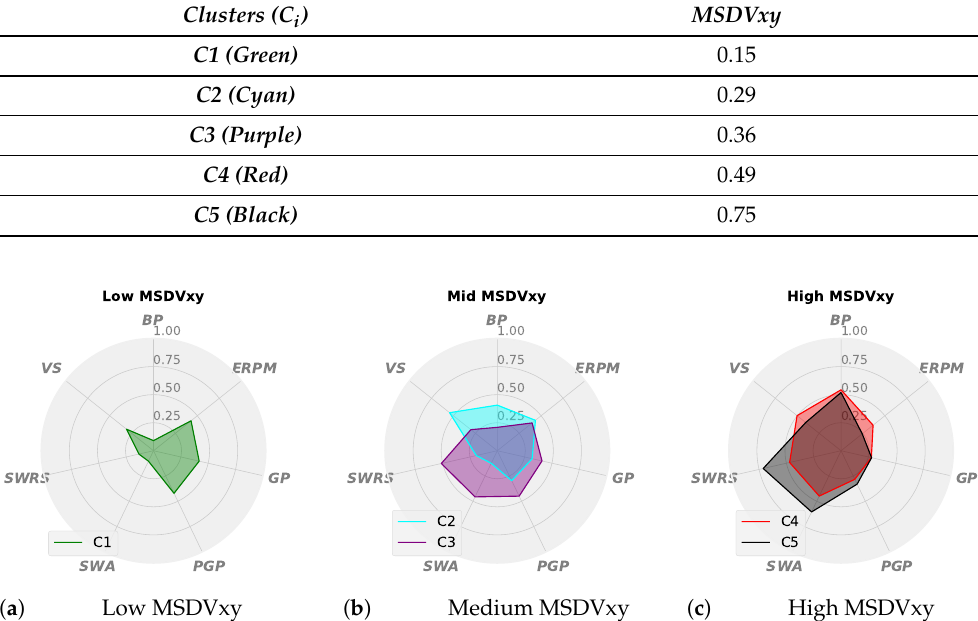
Figure 7. Spider graphs of low ( a ), medium ( b ), and high ( c ) MSDVxy clusters in the models trained with the RFE chosen variables. The visualized variables can be represented with values in the [0, 1] range since they are normalized. The combination of the mean of each variable gives us the characteristic form of each